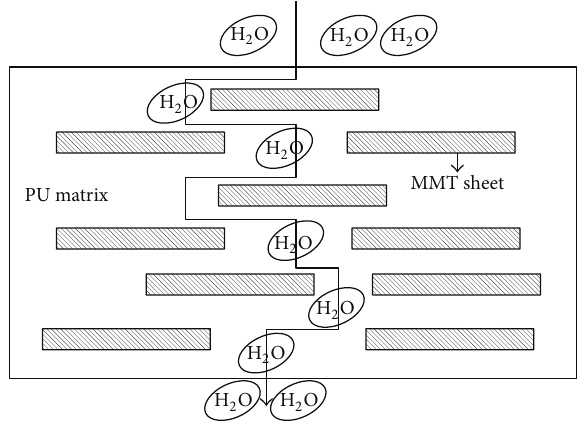
Figure 9: The ideal path of water molecules through OMMT/PU